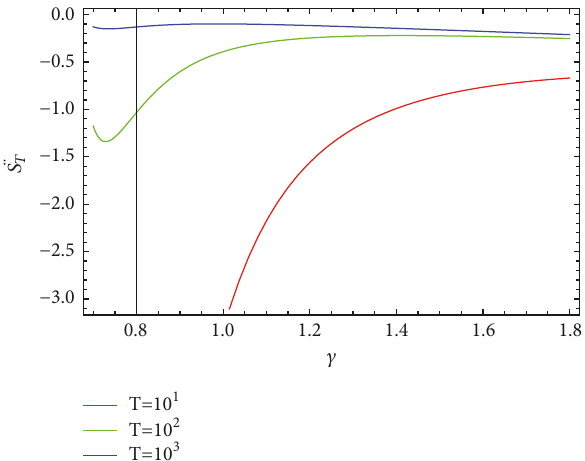
̇𝑆 𝛾 for Renyi entropy. 𝑇 versus